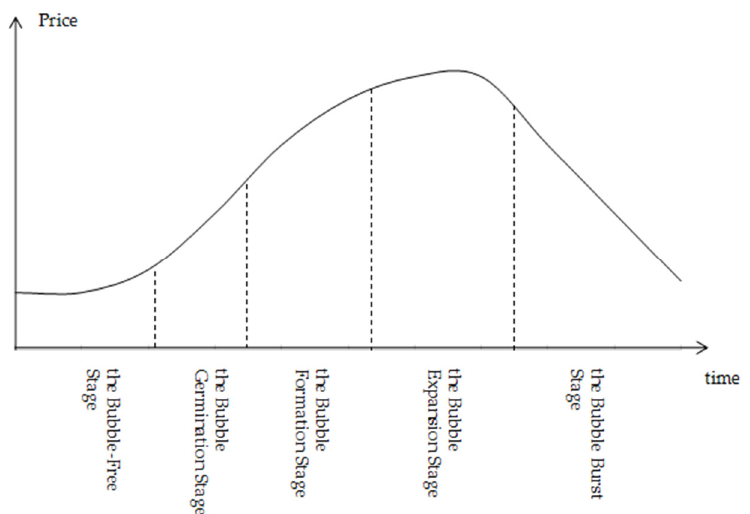
Figure 1. The evolution stage of housing bubbles